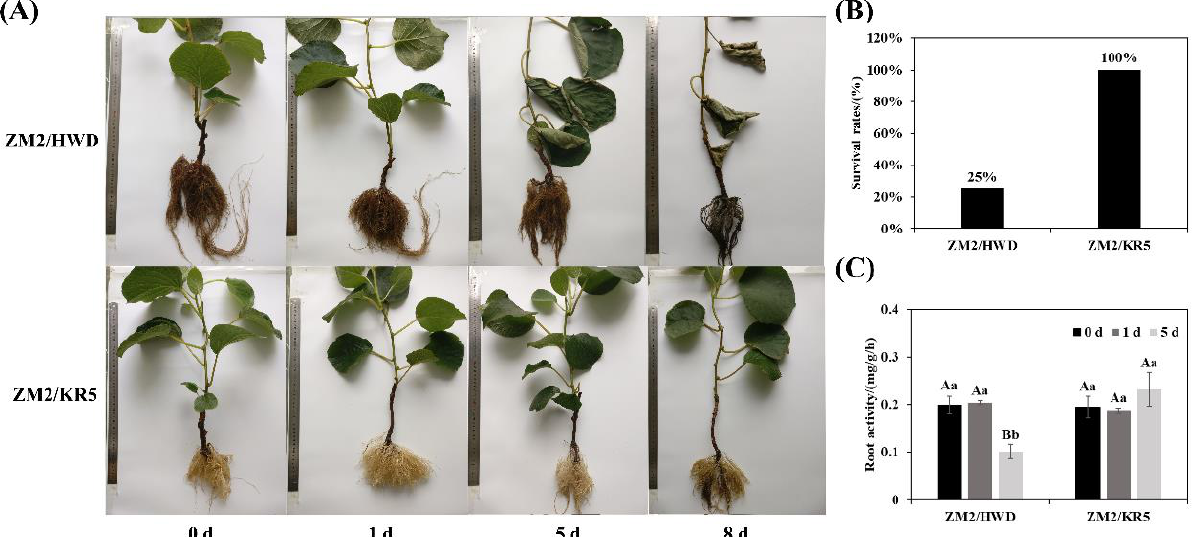
Figure 1. ( A ) Phenotype, ( B ) survival rate, and ( C ) root activity of two kiwifruit scion–rootstock combinations under waterlogging stress. ZM2/HWD and ZM2/KR5 indicate grafting ‘ Zhongmi 2 ′ onto ‘Hayward’ and KR5 rootstocks, respectively. Data are the mean values ± SD ( n = 3). Capital letters denote significant differences between the different waterlogging treatment stages for each scion–rootstock combination, and lower-case letters denote significant differences among the scion–rootstock combinations within the different waterlogging treatment stages according to a least significant difference (LSD) test ( p ≤ 0.05).